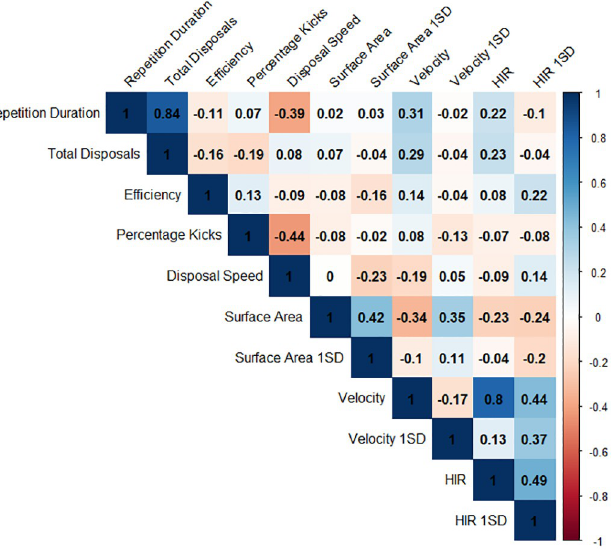
Fig 2. Correlogram of each behaviour metric. Each tile is labelled with the correlation coefficients between each metric and coloured according to this value as per the colour scale on the right (blue hues indicate a positive correlation and red hues indicate negative